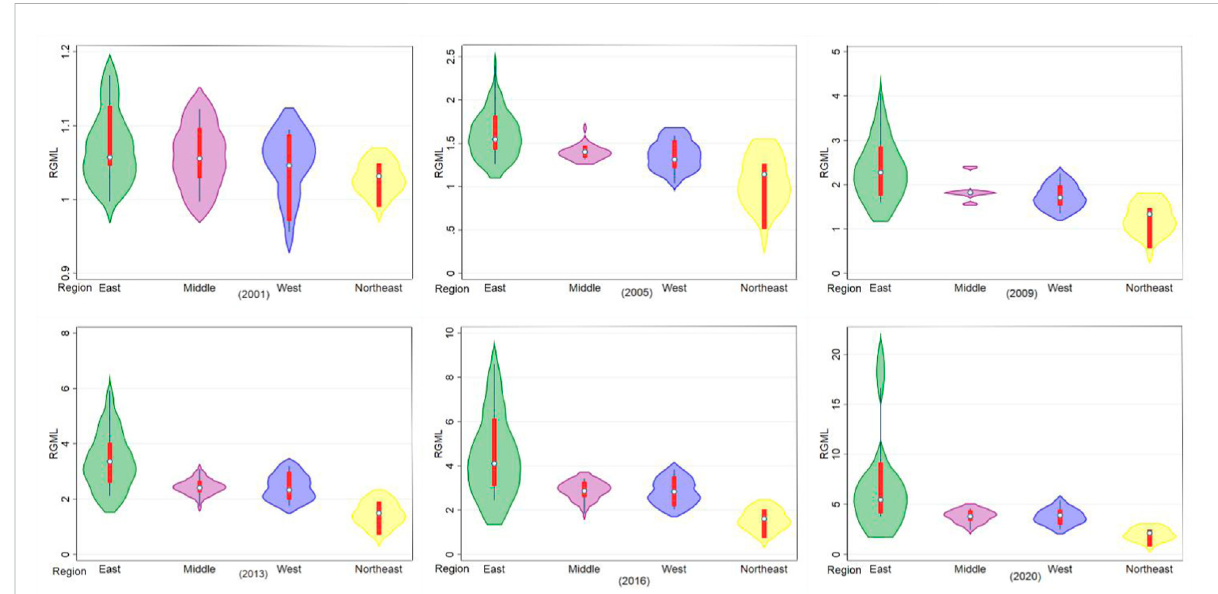
FIGURE 1 Dynamic distribution of ALTFP from 2001 to